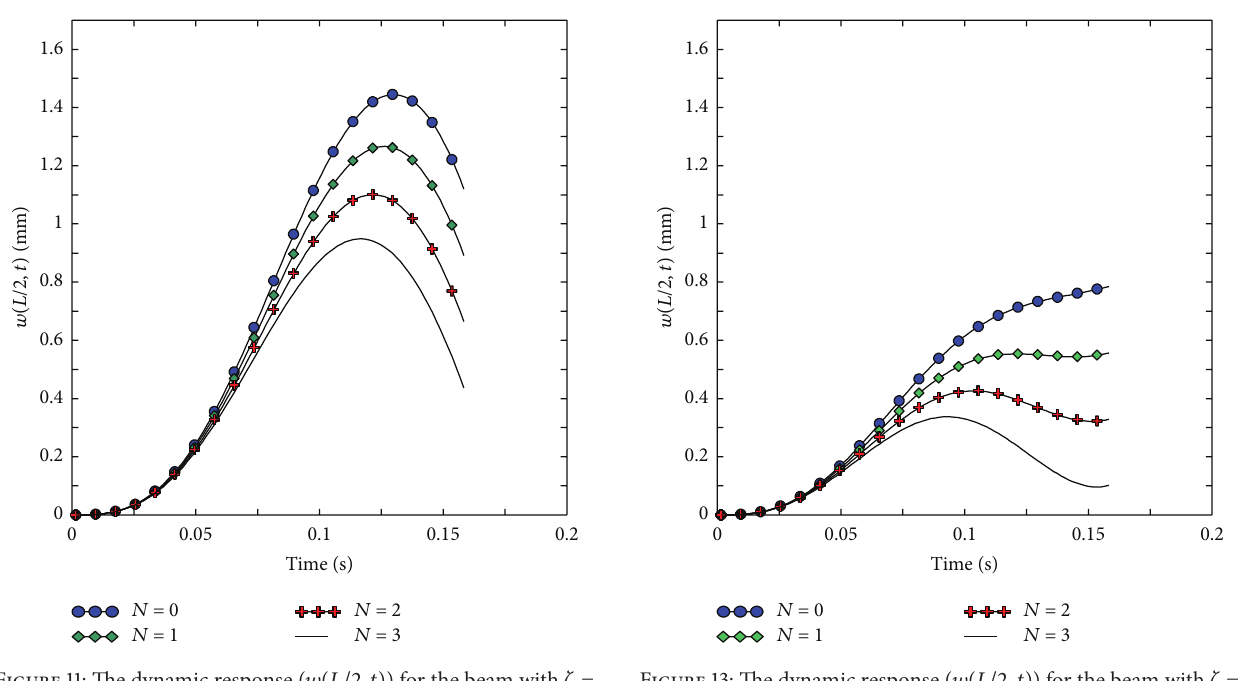
𝑁 = 1 , 𝑁 = 2 , and 𝑁 = 3 ) as (27.58%, 41.27%, 48.99%,